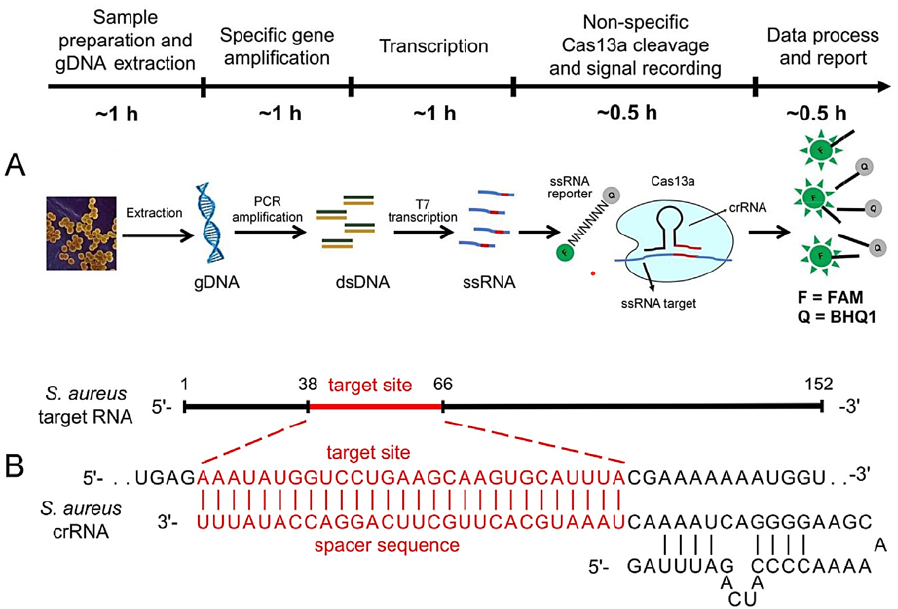
Figure 5. Schematic representation of a CRISPR-Cas 13a system for detection of Staphylococcus aureus ( S. aureus ): ( A ) detection mechanism and ( B ) schematics of target single-stranded RNA (ssRNA) and CRISPR RNA (crRNA). Reprinted/adapted with permission from Ref. [113]. 2020,